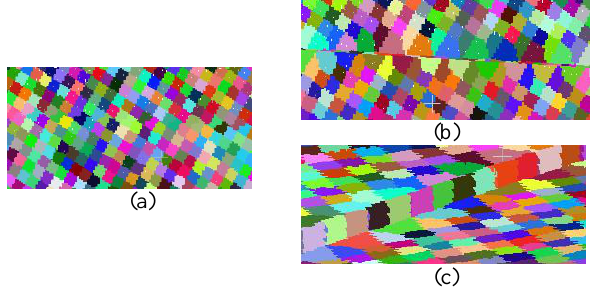
Figure 2. Super voxel generation: (a) regular grid cells; (b) irregular super voxels in top view; (c) irregular super voxels in side view.